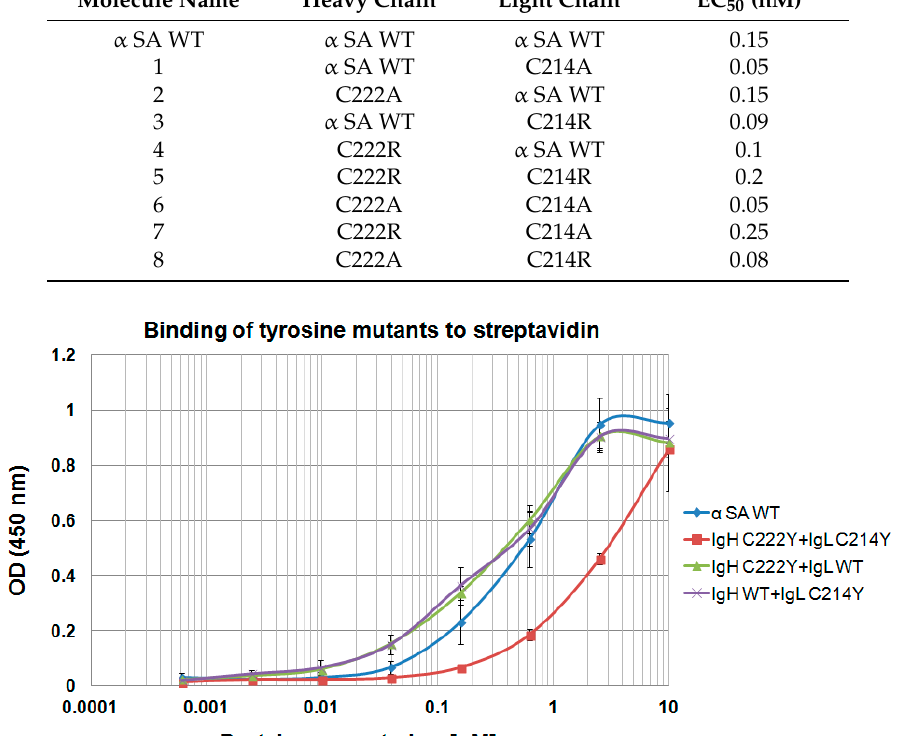
Figure 9. Evaluation of “disulfide-stabilized IgG”, anti SA “tyrosine mutants” binding to streptavidin by ELISA. Binding capability was evaluated by ELISA with SA as the coated antigen using X4 dilutions starting at 10 nM of each examined antibody; 3% skim milk was used for blocking; binding was detected using HRP-conjugated goat anti-human antibody (diluted 1:5000 in PBST). Error bars represent the standard deviation of the data.